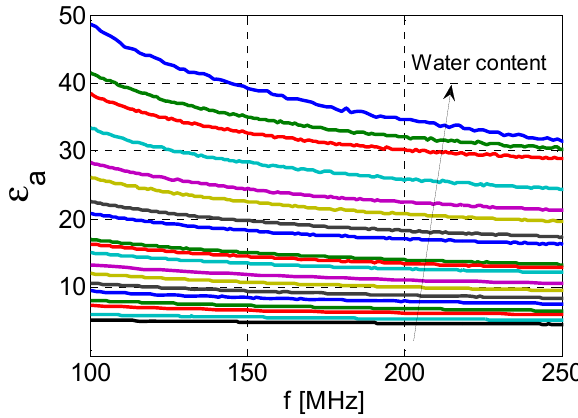
Figure 9. Apparent permittivity calculated from 19 measurements of the humogley soil sample with known water contents. The arrow indicates the increase of water